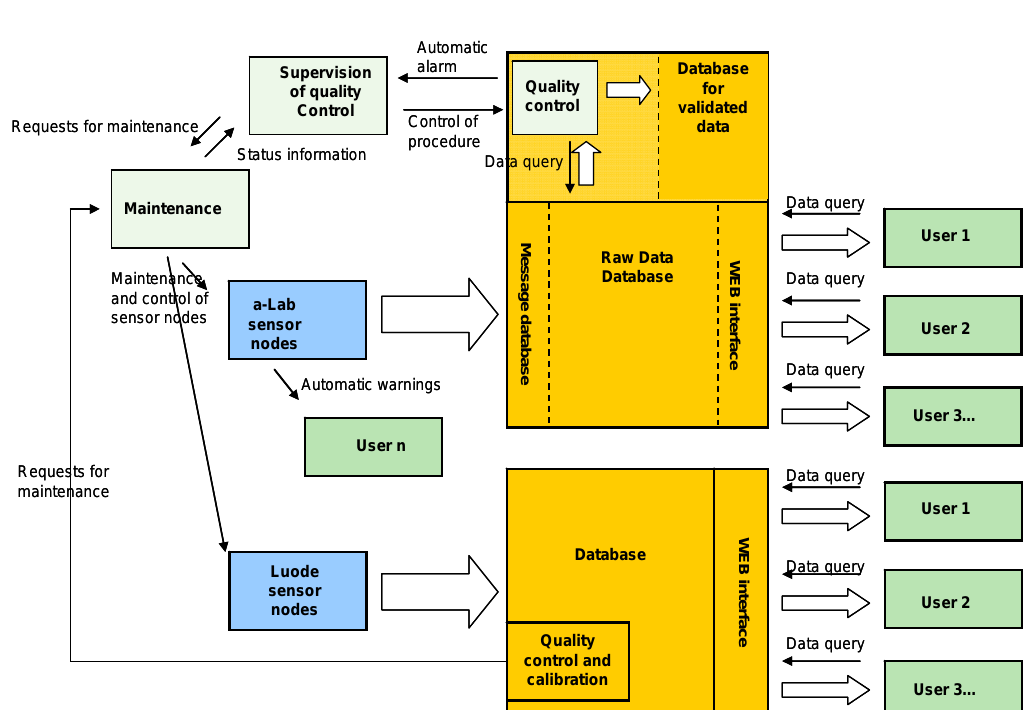
Figure 4. The data flow (white arrows) and communication system with main data services of SoilWeather WSN. a-Lab sensor nodes refer to nodes employing a-Weather station cores, Luode sensor nodes refer to nutrient measuring